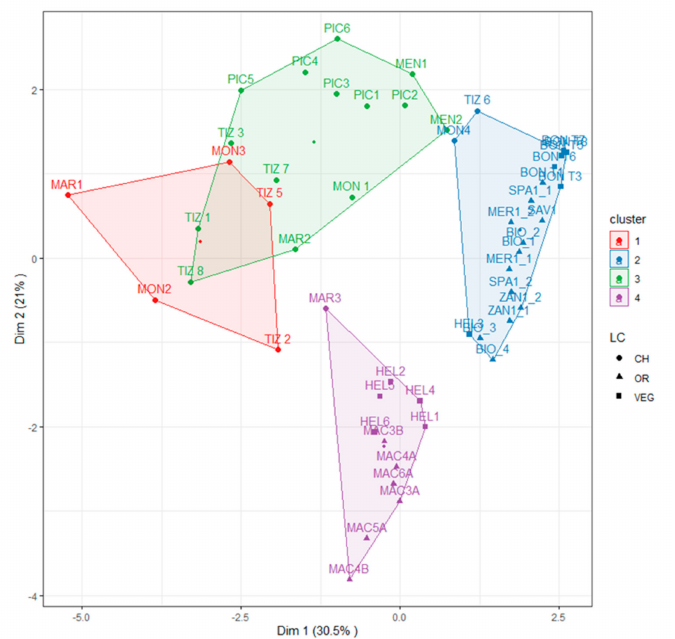
Figure 4. K-means clustering on the topsoils based on the concentrations of C and N and on the C:N ratio in organic matter fractions, depicted here on a PCA plot. CH, OR, and VEG refer to the main type of land use (CH—chestnut, OR—orchards, and VEG—other uses, such as grassland and the cultivation of vegetables and raspberries, as detailed in Table